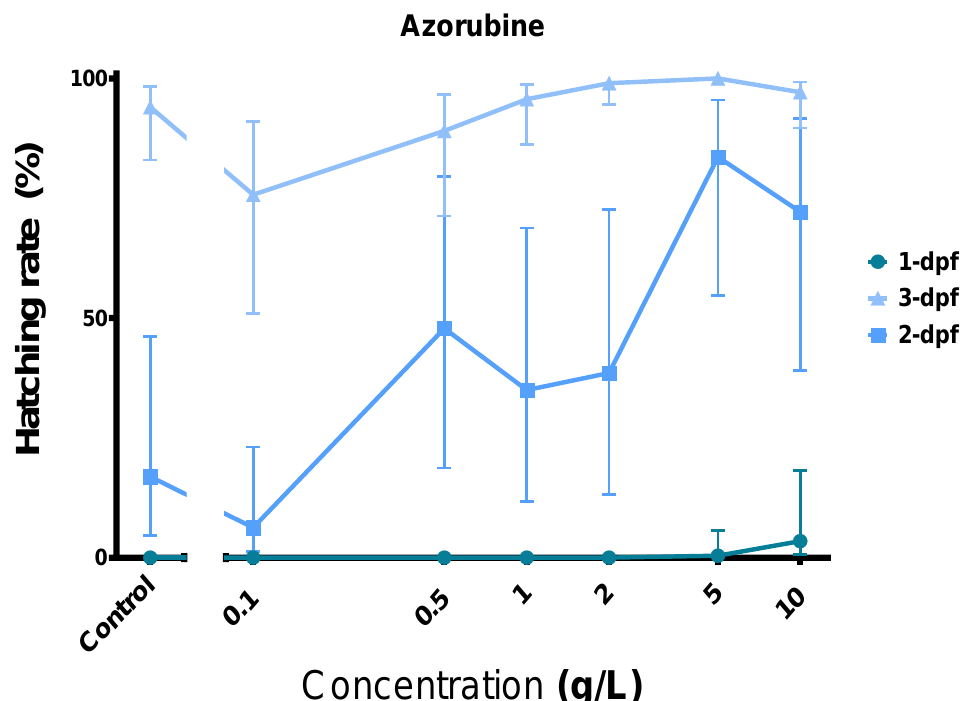
Figure 8. Azorubine stimulates embryo hatching even on day 1. Error bars showing 95% prediction interval.